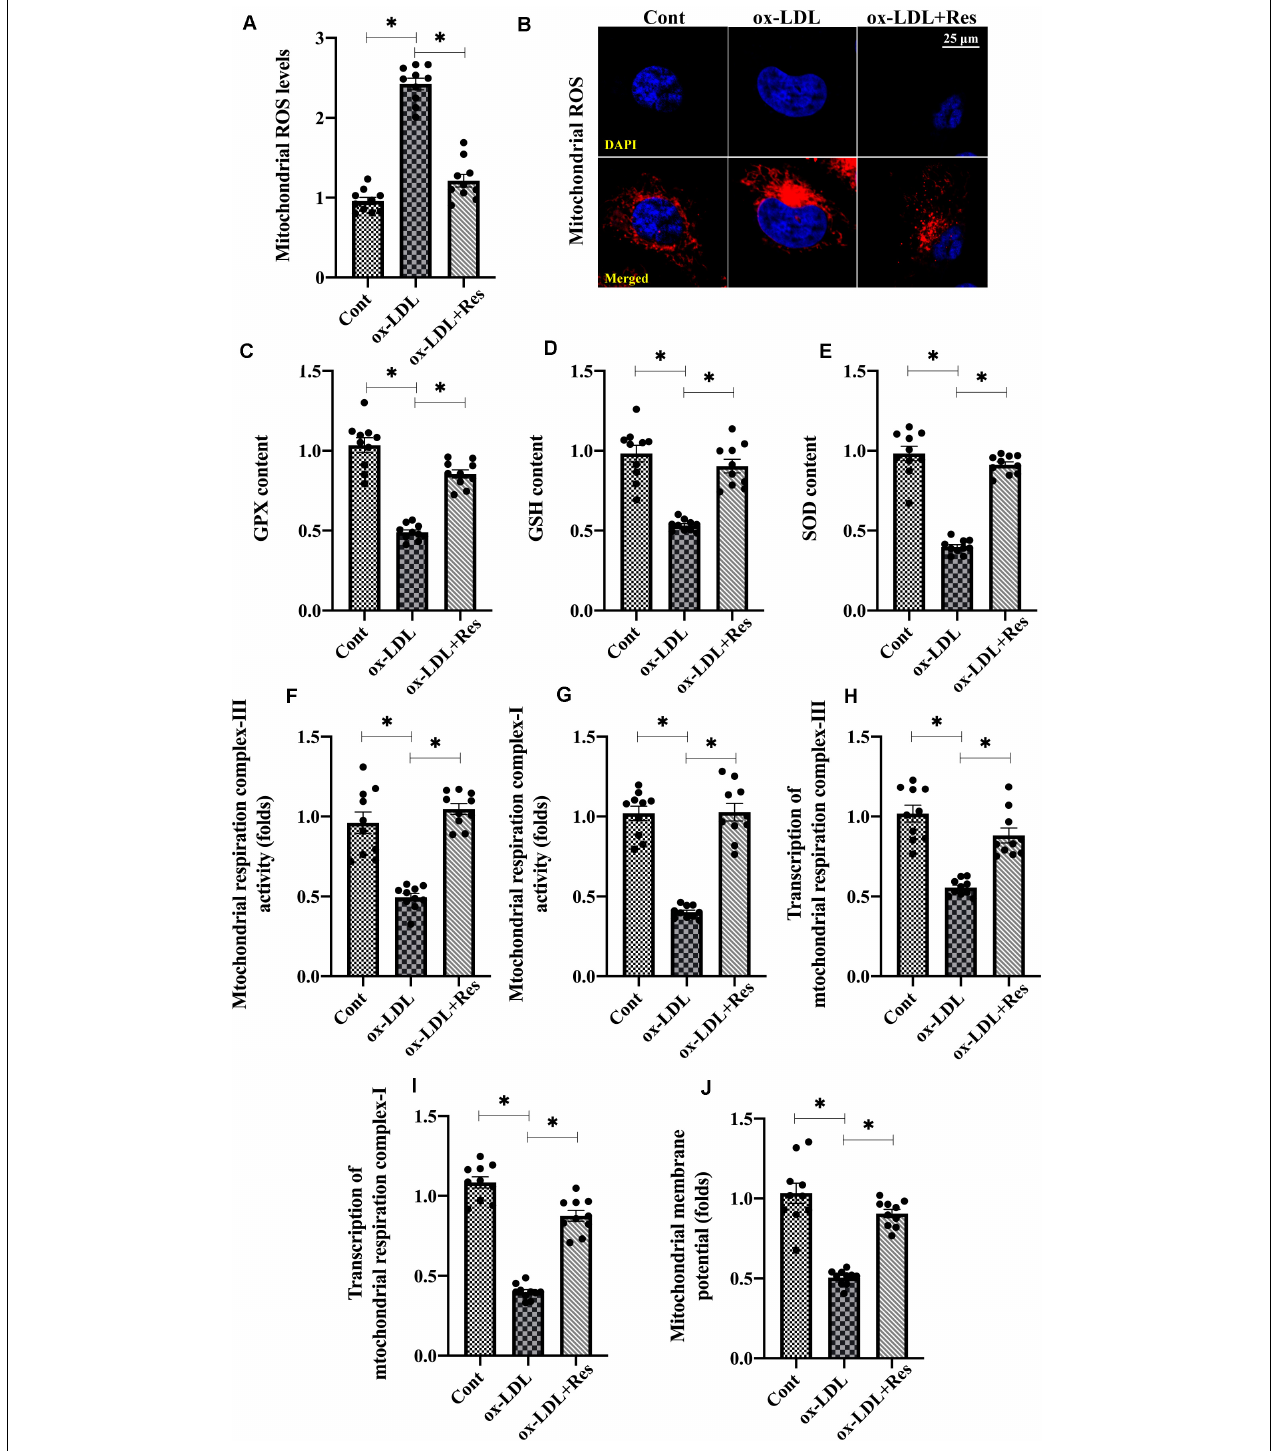
FIGURE 2 | Oxidative stress is inhibited by resveratrol in ox-LDL-treated endothelial cells. (A,B) Immunofluorescence assay for mitochondrial ROS in endothelial cells treated with ox-LDL in the presence or absence of resveratrol. (C–E) . ELISA was used to evaluate the activities of GSH, SOD, and GPX in endothelial cells. (F,G) . The activities of mitochondrial respiration complex I and III were measured through ELISA. (H,I) qPCR was used to analyze the transcription of mitochondrial respiration complex I and III. (J) JC-1 probe was used to stain mitochondrial membrane potential. The red-to-green fluorescence intensity was used to quality mitochondrial membrane potential. * p <